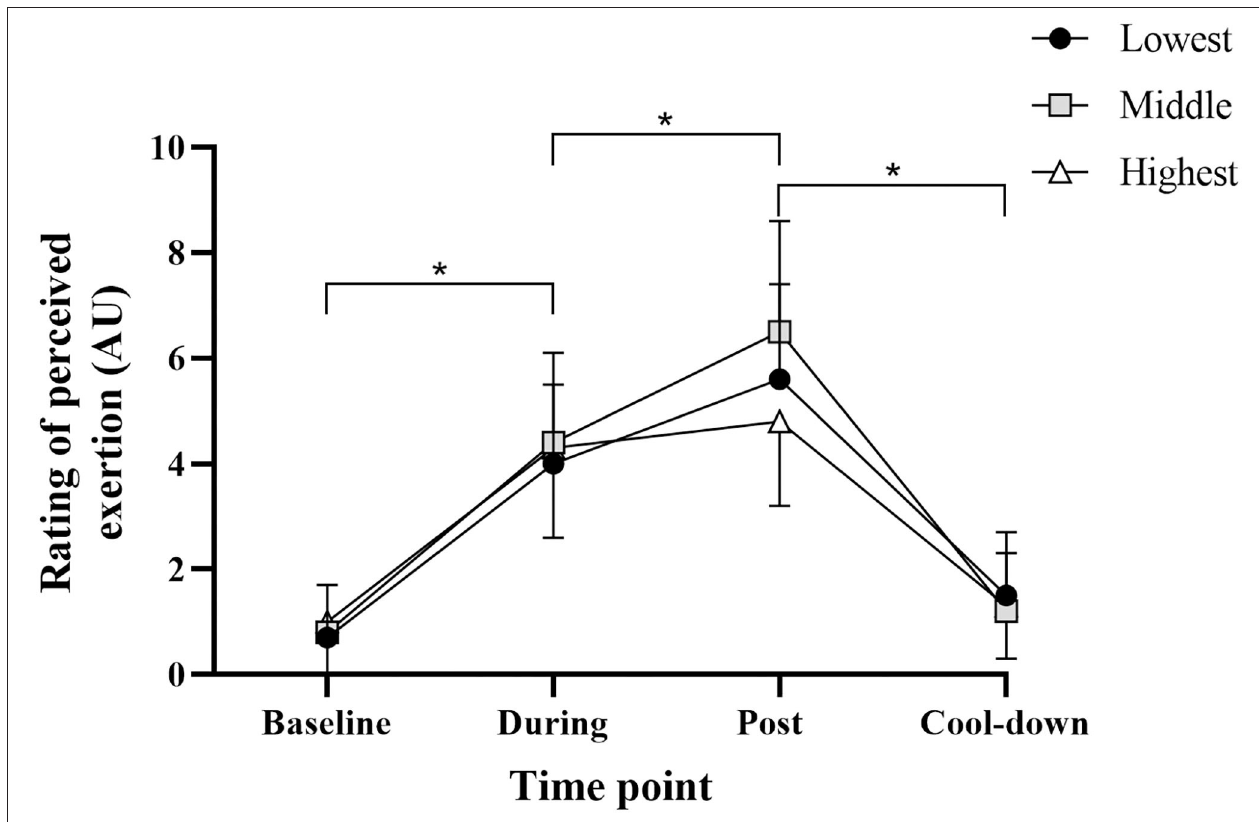
FIGURE 2 | Rating of perceived exertion for all groups at each time point. Data are mean (SD). *Significant pairwise comparison ( p < 0.001). valence increased significantly from post to cool down (p = 0.018, d unb = 0.47). This suggests a degree of “affective rebound” at